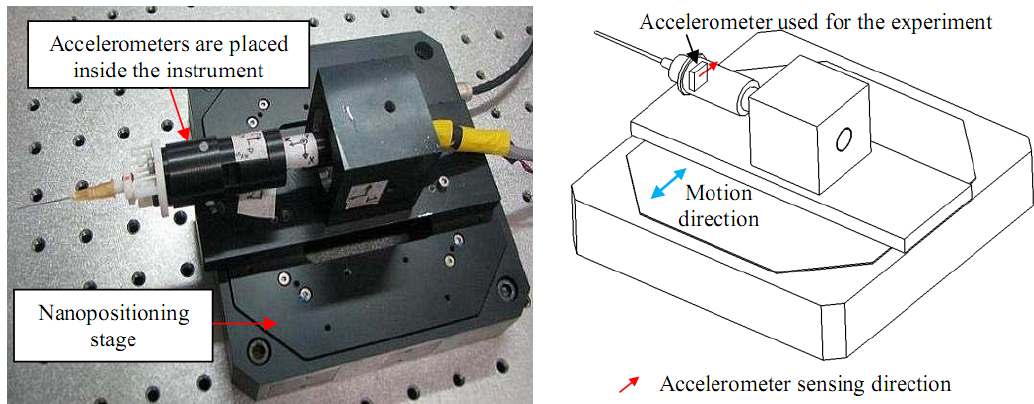
Figure 16. A picture (Left) and a schematic drawing (right) of the experimental